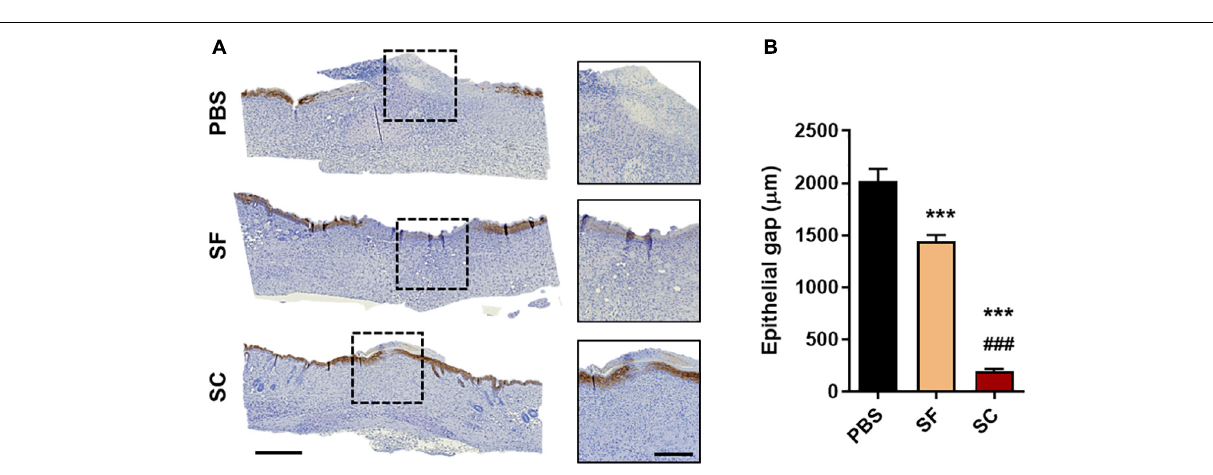
Frontiers in Bioengineering and Biotechnology |